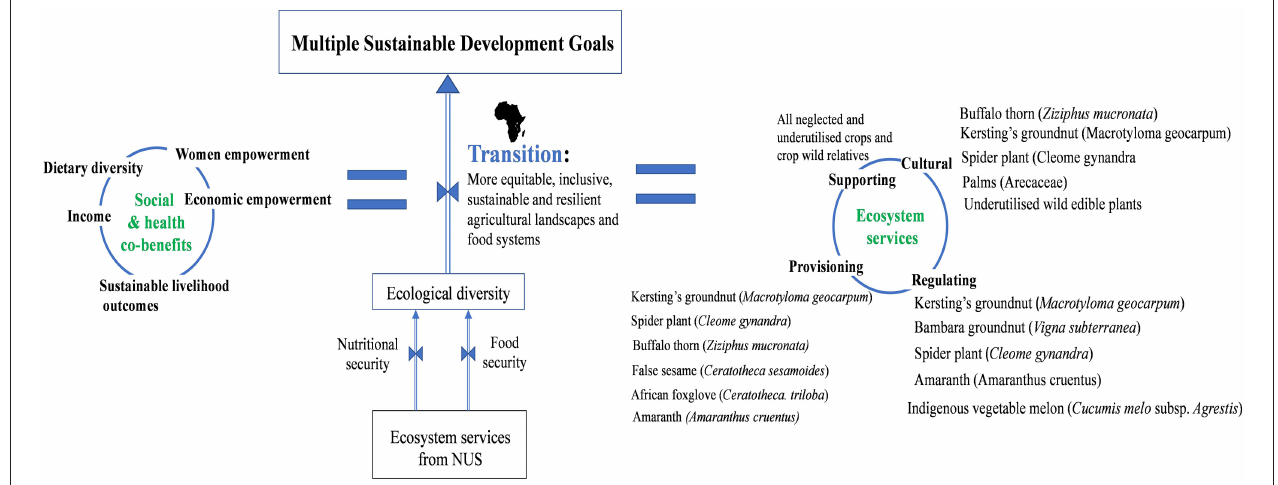
FIGURE 5 | NUS have essentially been considered potential crops to address nutritional and food security. However, from an ecological integrity perspective, NUS could increase on-farm ecological diversity. In effect, the current systematic review has determined the various ecosystem services: supporting, cultural, regulating and provisioning. The focus is on African small-scale agriculture due to the importance of NUS to food and nutrition and culture on the continent ( Mayes et al., 2012; Baa-Poku, 2018; Kasolo et al., 2018 ) and the growing NUS research focus. From an even broader perspective, NUS crops could provide a myriad of social and health co-benefits, including dietary diversity, economic and women empowerment, income and sustainable livelihood outcomes. Altogether, these benefits would form part of a dynamic transition system to achieve multiple Sustainable Development Goals